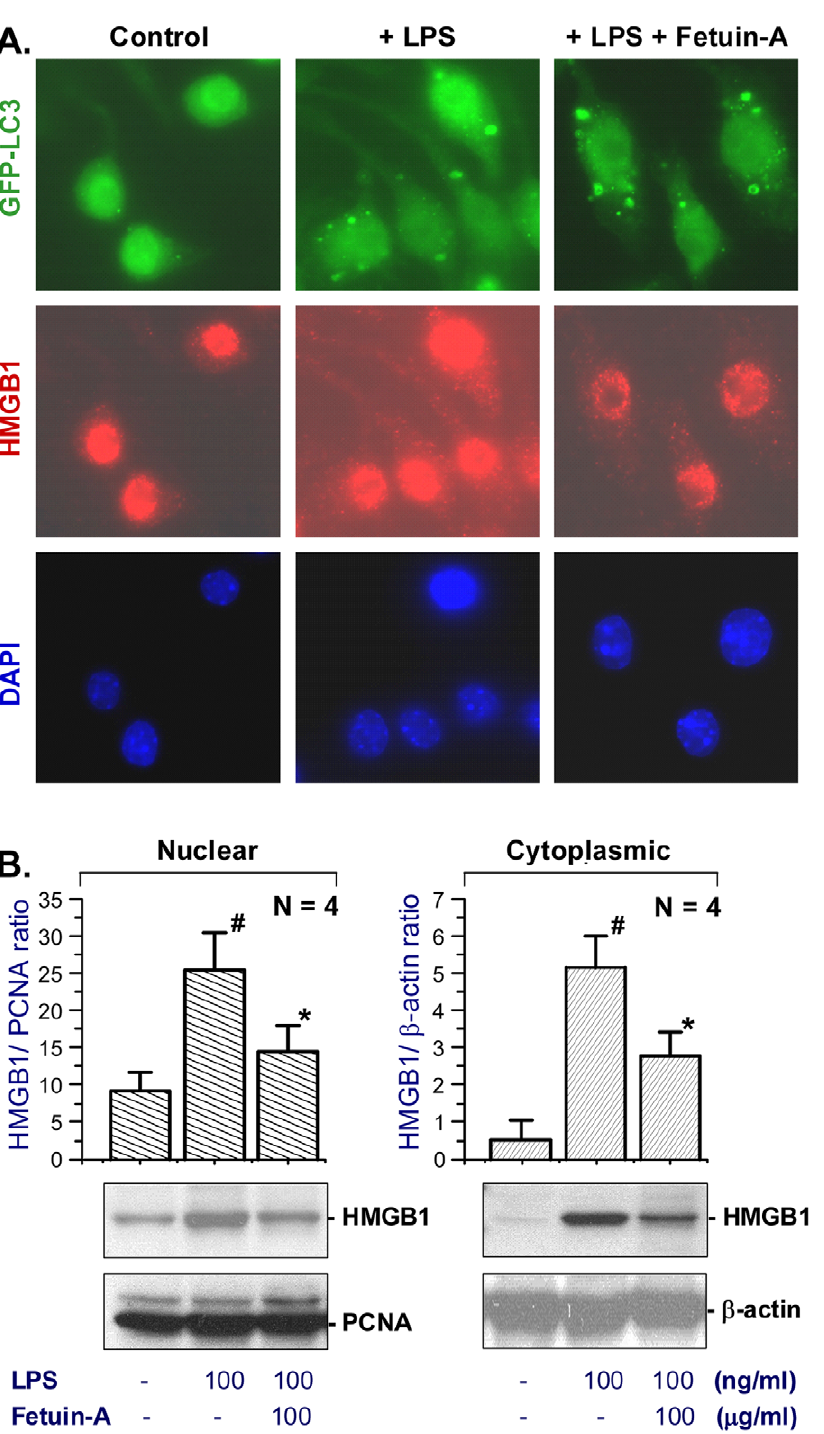
Figure 5. Fetuin-A did not affect LPS-induced formation of LC3-containing cytoplasmic vesicles, but attenuated cytoplasmic HMGB1 levels. A). Fetuin-A did not affect LPS-induced formation of autophagosomes, but reduced cytoplasmic HMGB1 staining . GFP-LC3 transfected macrophages were stimulated with LPS (200 ng/ml) in the absence or presence of fetuin-A, and immunostained with HMGB1-specific antibodies. Note that HMGB1 was predominantly localized in the nuclear region of un-stimulated macrophages (control) ( left panels ), but in both cytoplasmic and nuclear regions of LPS-stimulated macrophages ( middle panels ). Fetuin-A reduced cytoplasmic HMGB1 staining in LPS-stimulated macrophages (LPS + fetuin-A). Images are representative of three independent experiments with similar results. B). Fetuin-A reduced cytoplasmic and nuclear HMGB1 levels in LPS-stimulated macrophages. Thioglycollate-elicited peritoneal murine macrophages were stimulated with LPS in the absence or presence of fetuin-A (100 m g/ml) for 16 h, and cytoplasmic nuclear fractions were isolated, and assayed for levels of HMGB1 with reference to a nuclear (PCNA) or cytoplasmic ( b -actin) markers. Blots are representative of two independent experiments with similar results. Bar graphs were mean 6 SD of two independent experiments in duplicates (N=4). # , P , 0.05 vs negative control ‘‘- LPS’’; *, P , 0.05 vs positive control ‘‘ + LPS’’.